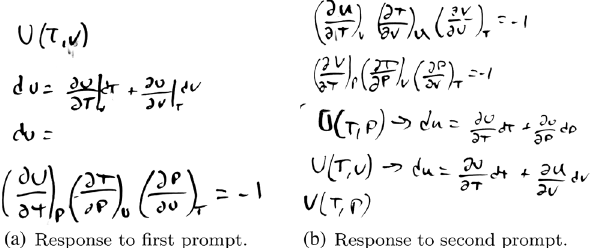
FIG. 8. Student 4 ’ s AD strategy. (a) During the first stage, he failed to transform the given representations into functional forms. (b) In the second stage, he failed to consolidate the differentials into a single